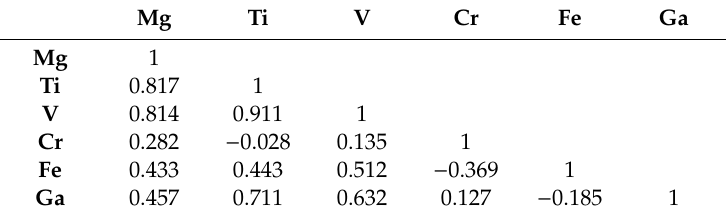
Table 14. Correlation table for trace elements of Sri Lankan blue and pink sapphires and rubies.